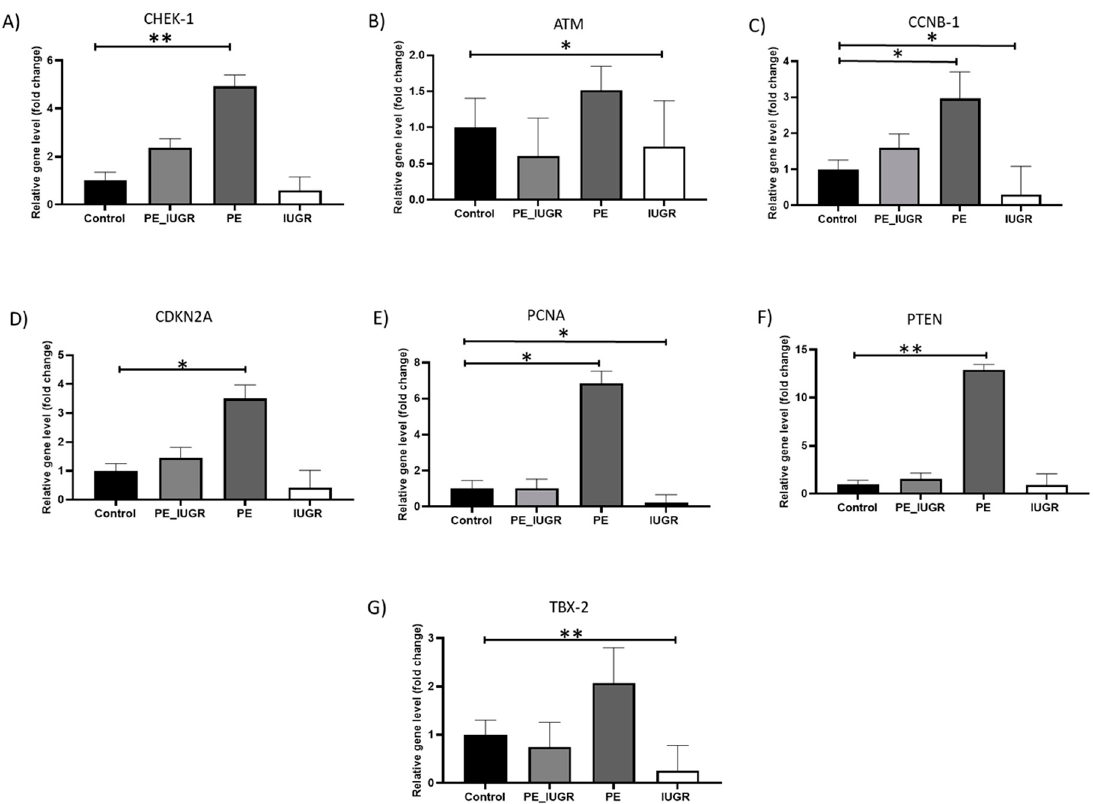
Figure 1. Senescence-associated gene expression in placental tissue in pre-eclampsia and IUGR. ( A ) CHEK-1 expression in pre-eclampsia only was significantly elevated ( p = 0.006); ( B ) ATM was significantly decreased in IUGR ( p = 0.02); ( C ) CCNB-1 was significantly elevated in pre-eclampsia only ( p = 0.028), whereas it was significantly reduced in IUGR ( p = 0.036); ( D ) CDKN2A was significantly elevated in pre-eclampsia only ( p = 0.012); ( E ) PCNA was significantly elevated in pre-eclampsia only ( p = 0.014), whereas it was significantly decreased in IUGR ( p = 0.04); ( F ) PTEN was significantly elevated in pre-eclampsia only ( p = 0.005); ( G ) TBX-2 was significantly reduced in IUGR only ( p = 0.005). All measurements were relative gene expression compared with controls. Data are mean fold change compared with controls at level 1 ± SD, p < 0.05; p -value < 0.05, it is flagged with one star (*) and p -value < 0.01, it is flagged with two stars (**).